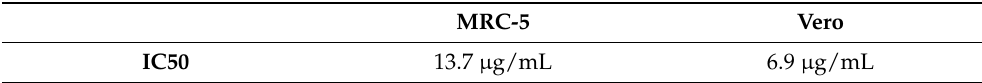
Table 6. Inhibitory concentration of C7 for MRC-5 and Vero cells ( n = 2).